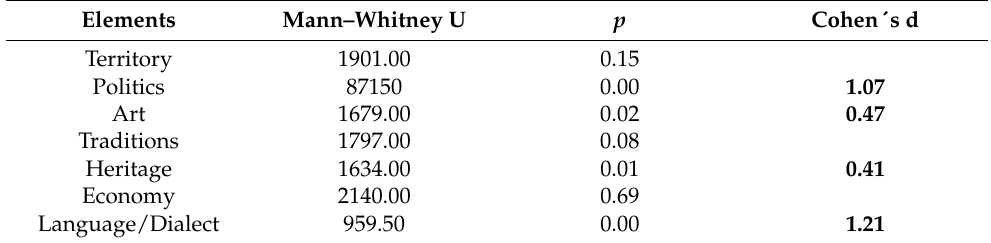
Table 8. Test of contrast between groups on elements for working on identities in the